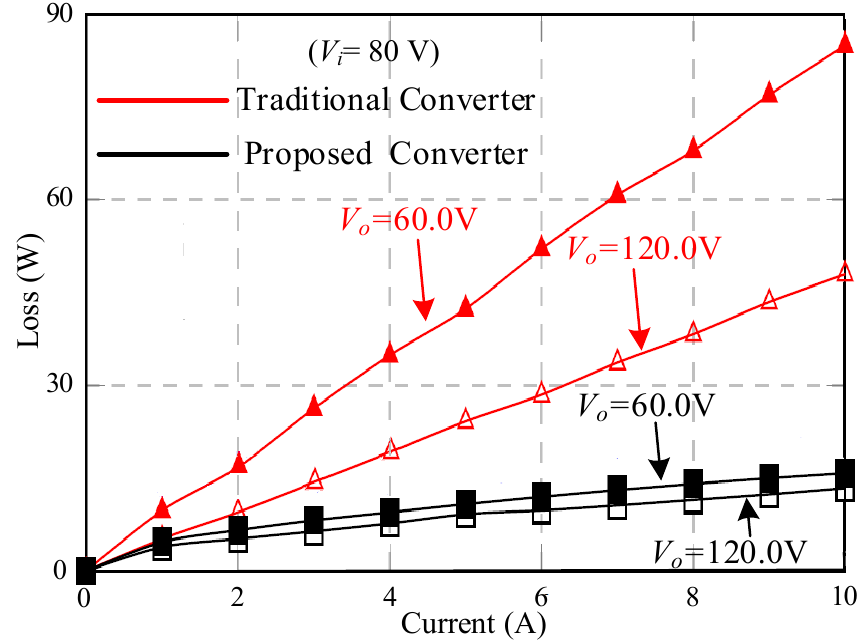
Figure 6. Switching losses waveforms of two LC-DAB converters.